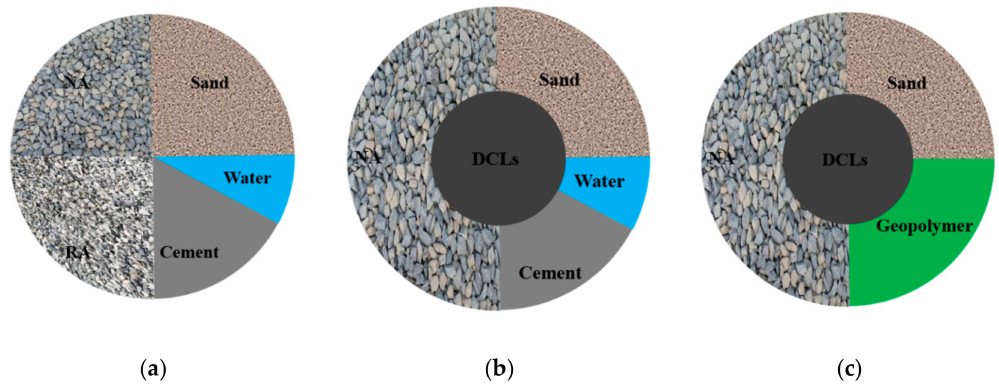
Figure 1. Concept of recycled aggregate concrete and recycled lump concrete. ( a ) Recycled aggregate